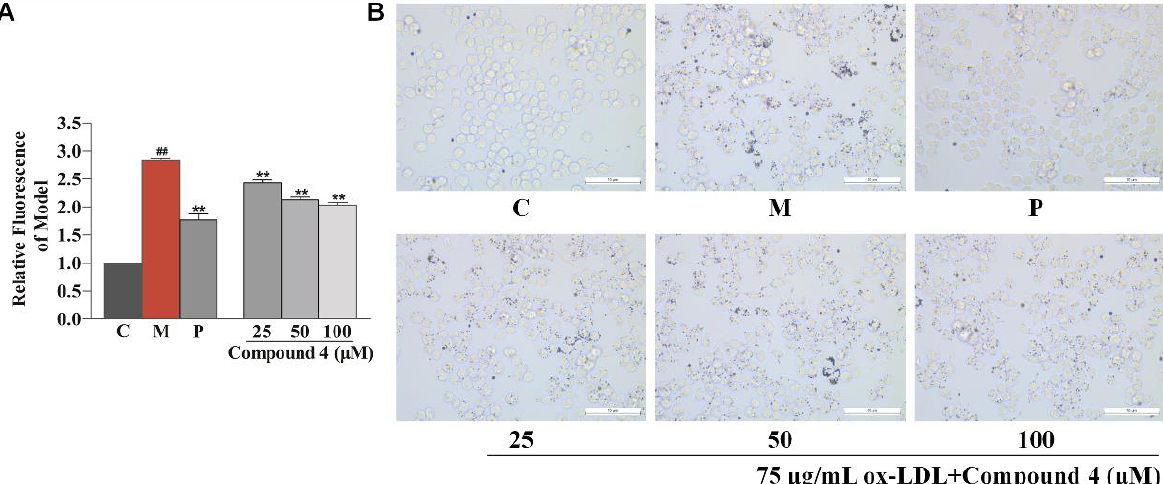
Figure 6. Inhibitory effects of compound 4 against lipid drops accumulation in ox-LDL-treated RAW264.7 cells measured by Oil Red O staining. ( A ) Oil Red O content evaluated by isopropanol extraction. ( B ) Oil Red O staining images of RAW264.7 cells (magnification 400 × ). Results are expressed as the mean ± SD ( n = 3). Model group was subject to 75 µ g/mL ox-LDL. Positive group was subject to 25 µ M simvastatin. ## p < 0.01 vs. control group; ** p < 0.01 vs. model group.